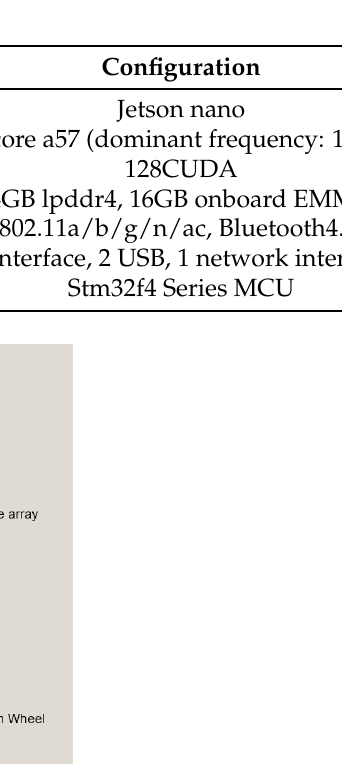
Figure 1. UCAR structure diagram.